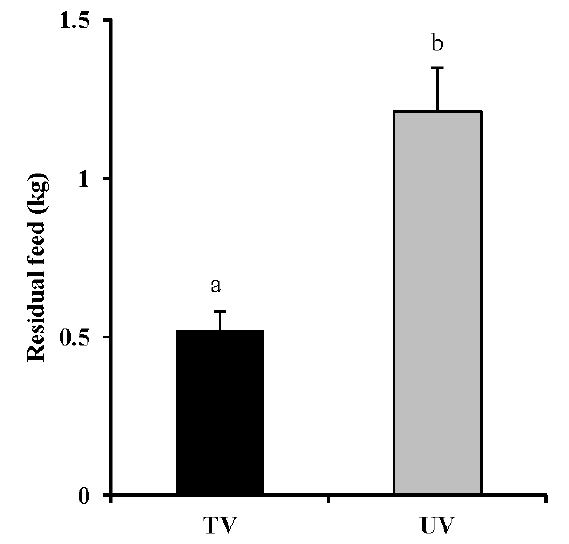
Figure 6. Changes in residual feed in the unventilated (UV) and tunnel- ventilated (TV) systems. Values represent the mean±standard error (n = 21). Values with different superscripts ( a,b ) differ significantly (p<0.05).